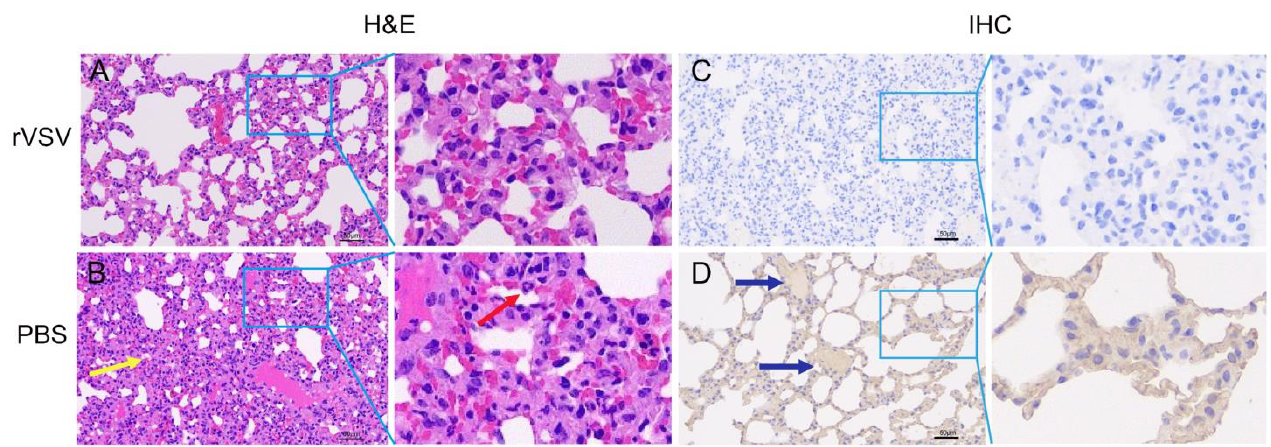
Figure 7. Lung pathology was reduced in rVSV ∆ G-Sdel-eGFP-vaccinated Syrian hamsters following challenge with the SARS-CoV-2 Delta variant. ( A – D ) The histopathology and immunohistochemistry (IHC) of Syrian hamster lungs are shown. ( A ) H&E stained sections of lung tissues obtained from rVSV-vaccinated mice shows no pathology after challenge. ( B ) The lungs of PBS-immunized mice showed marked pulmonary lesions, including severe parenchyma inflammation (the red arrow) and consolidation of pulmonary parenchyma (the yellow arrow) in H&E staining sections. ( C , D ) Numerous immunoreactivities (the blue arrow) are observed in the lung of the mock group, but no immunoreactivity was observed in the rVSV-vaccinated group. The scale bar = 50 μm.